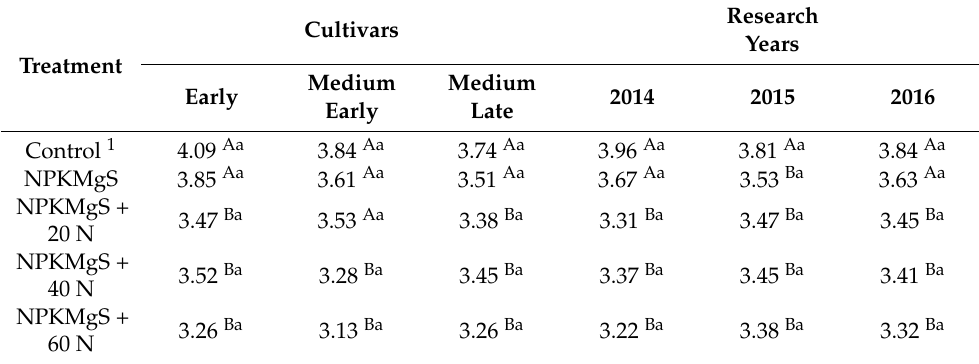
Table 5. Acid phosphatase activity in soil (mmol PNP h –1 kg –1